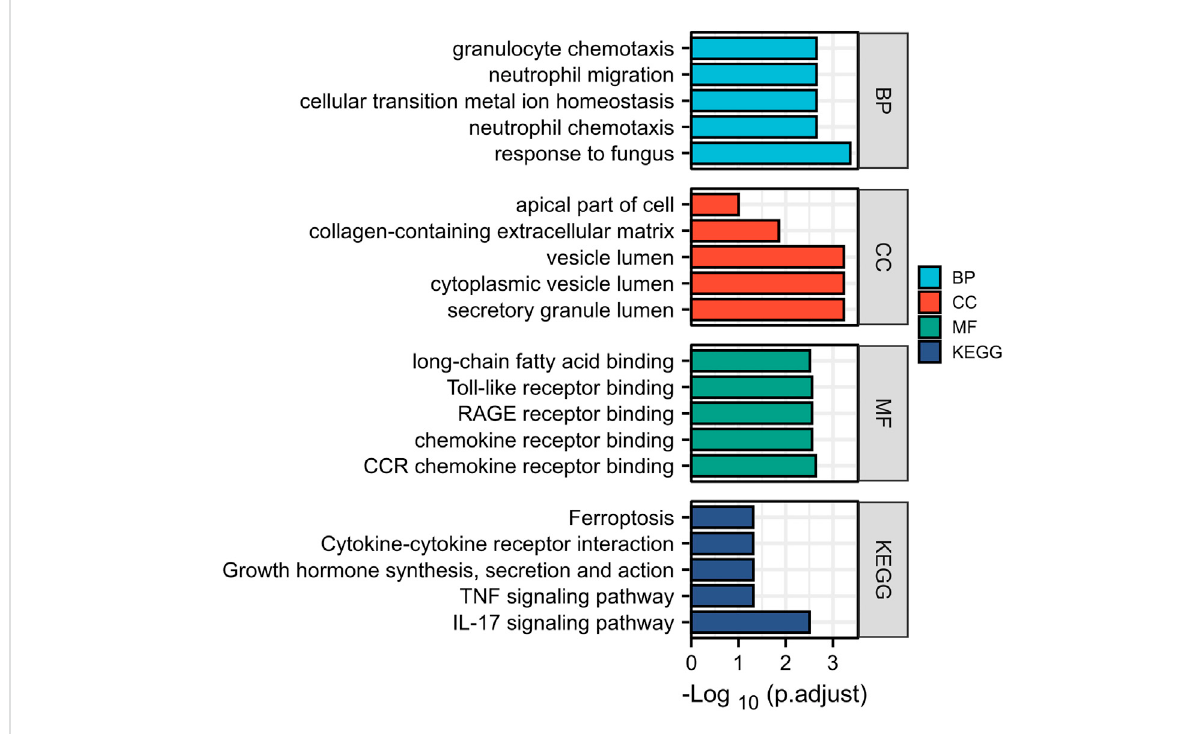
FIGURE 3 GO enrichment analysis and the KEGG pathway enrichment analysis of DEGs.